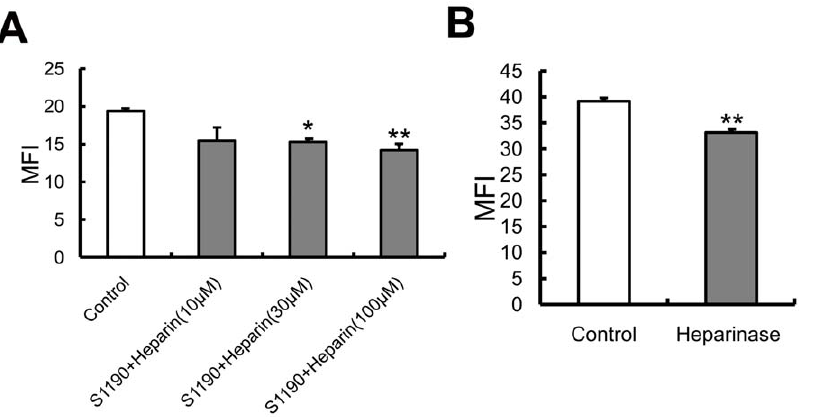
Figure 5. Addition of exogenous heparin and enzymatic removal of HS chains by heparinase reduce spike protein binding to HEK293E/ACE2-Myc cells. ( A ) Heparin blocks the binding of S1190-Fc to HEK293E/ACE2-Myc cells. HEK293E/ACE2-Myc cells were incubated with heparin for 10 min at the concentration of 10 m M, 30 m M or 100 m M. S1190-Fc was added to each group and incubated at 4 u C for 1 h. The MFI of each group was measured as described above. Error bars represent the SD of three independent experiments. *** P , 0.001, **P , 0.01 and *P , 0.05. ( B ) Enzymatic degradation of cell-surface heparan sulfate (HS) chains reduces S1190-Fc binding. After treatment with 10 U of heparinase I, the cells were incubated with S1190-Fc at 4 u C for 1 h. The MFI test was performed using the same method as above.